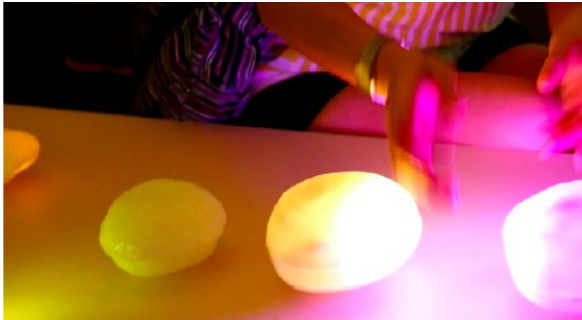
Figure 2 | Digital scents integrated with lighting to evoke sensorial imagination.